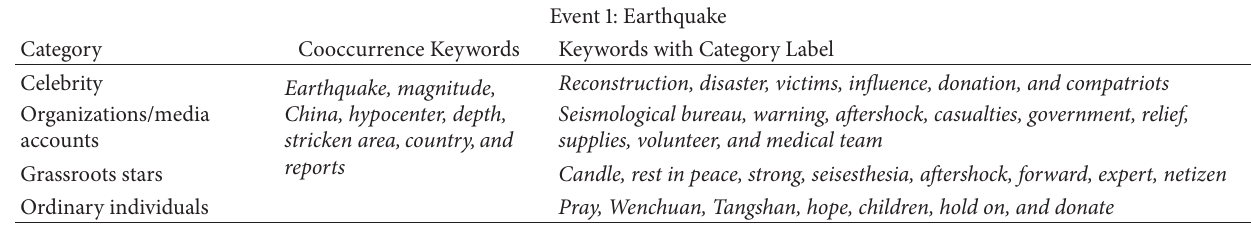
Table 5: Keywords distribution on the event of “Earthquake.”